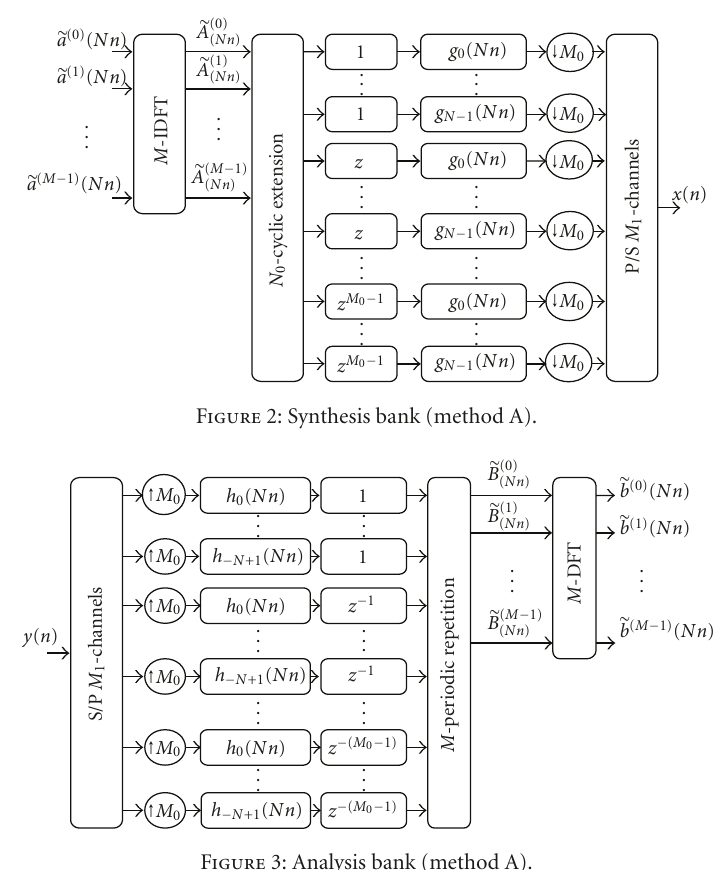
Figure 3: Analysis bank (method